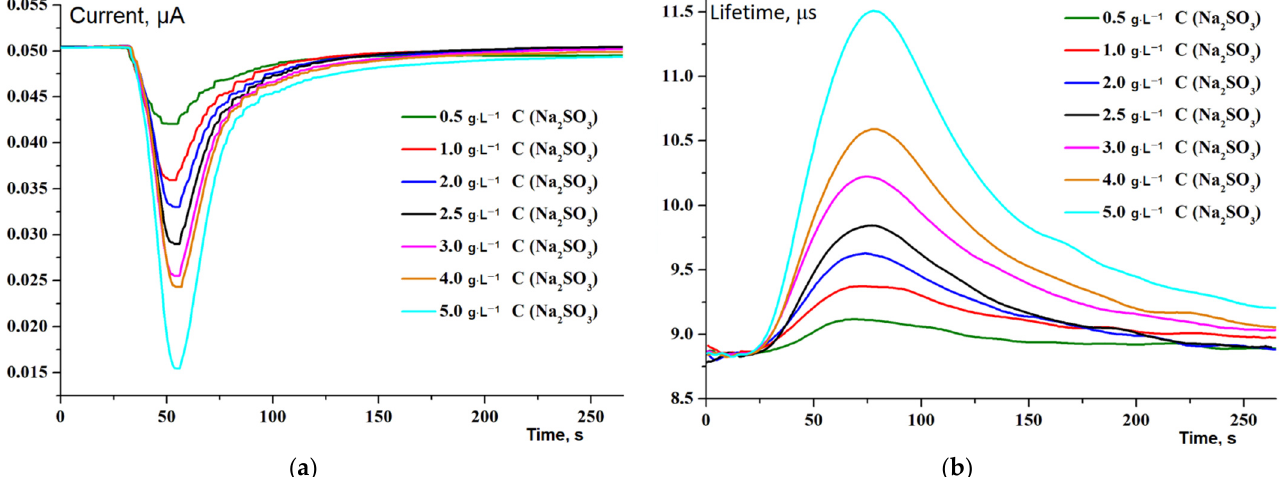
Figure 2. Dependences of the oxygen concentration in the analyzed microvolume on time from the moment the sample was injected into the flow for different concentrations: ( a )—Clark electrode cur- rent; ( b )—indicator dye excited state lifetime. Flow rate 1 mL·min − 1 , loop volume 0.2 ml.